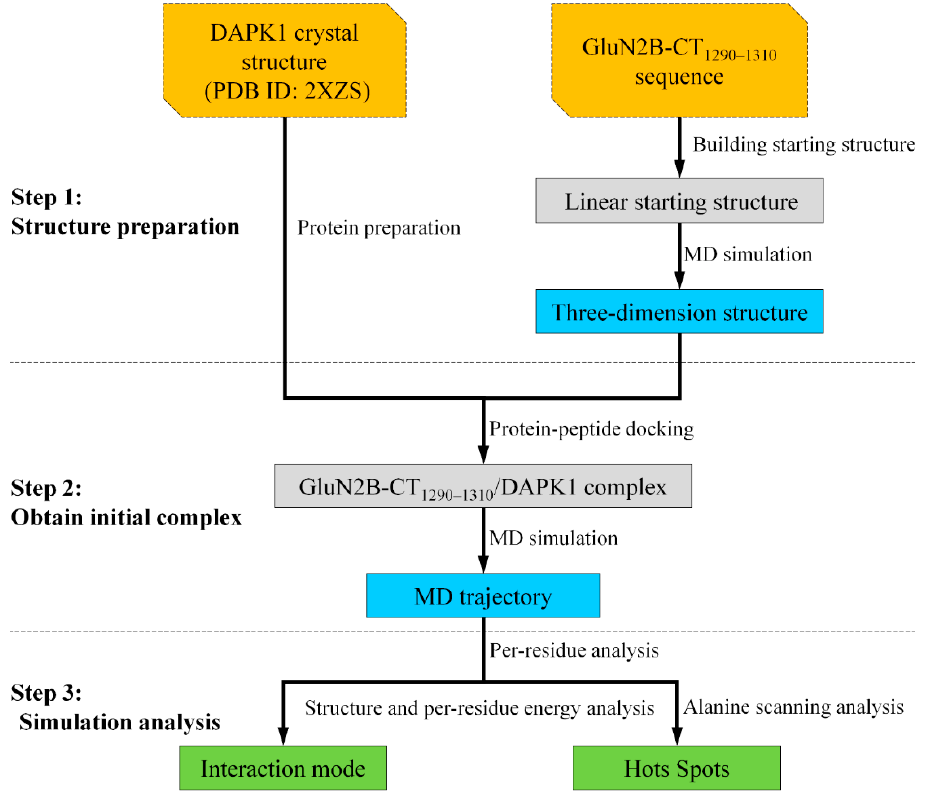
Figure 1. Flowchart of predicting GluN2B-CT 1290-1310 /DAPK1 interaction in this work. DAPK1: death-associated protein kinase 1 ; MD: molecular dynamics.